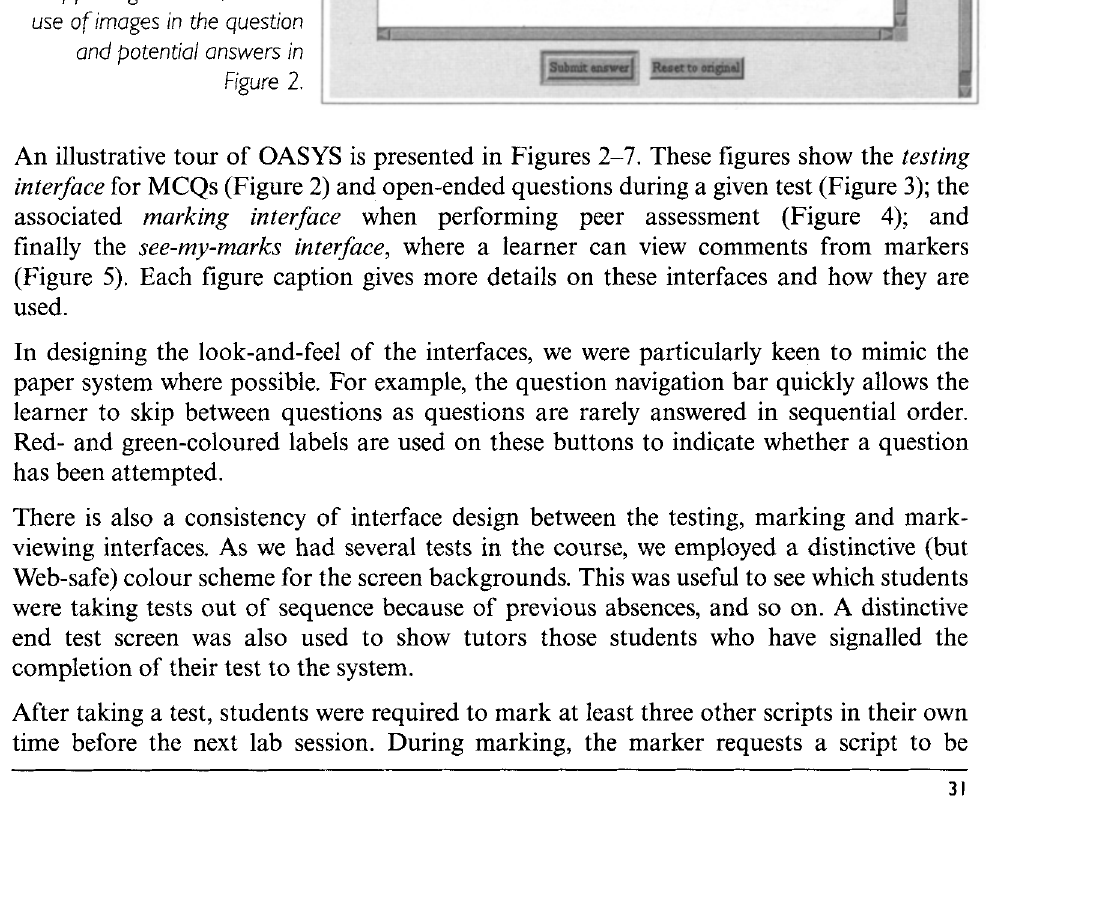
Figure 3: Entirely free answers are a major feature of OASYS - free responses are marked by other learners. Also note here the use of HTML links to supporting material, and the use of images in the question and potential answers